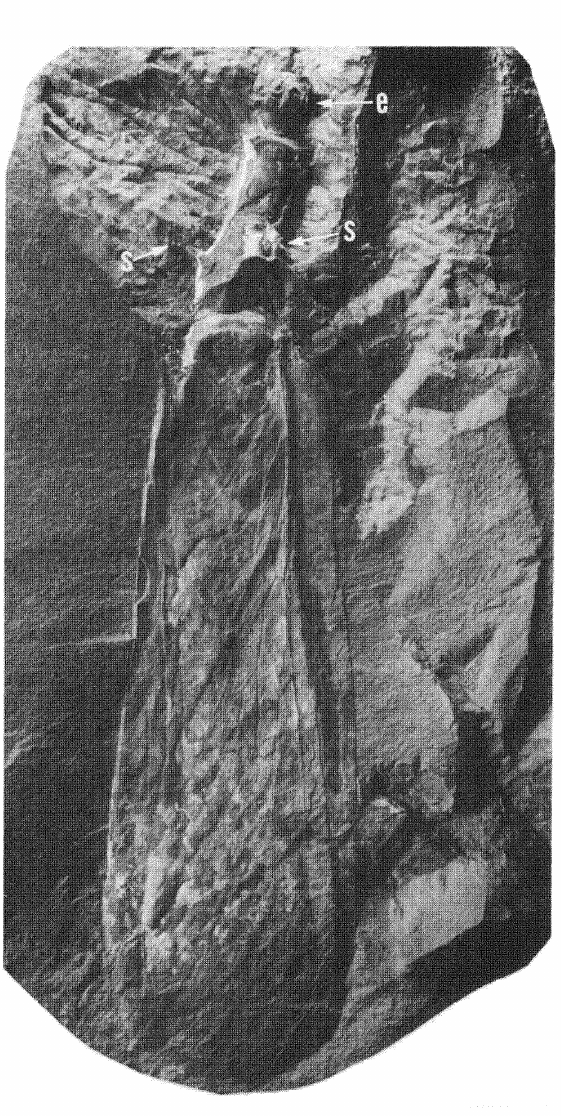
Fig. 5. Gerarus vetus, photograph of specimen FMNH PE 32024. Note the narrow prothorax, and head, on which a compound eye is visible. Length of wing, 52 mm. e eye;